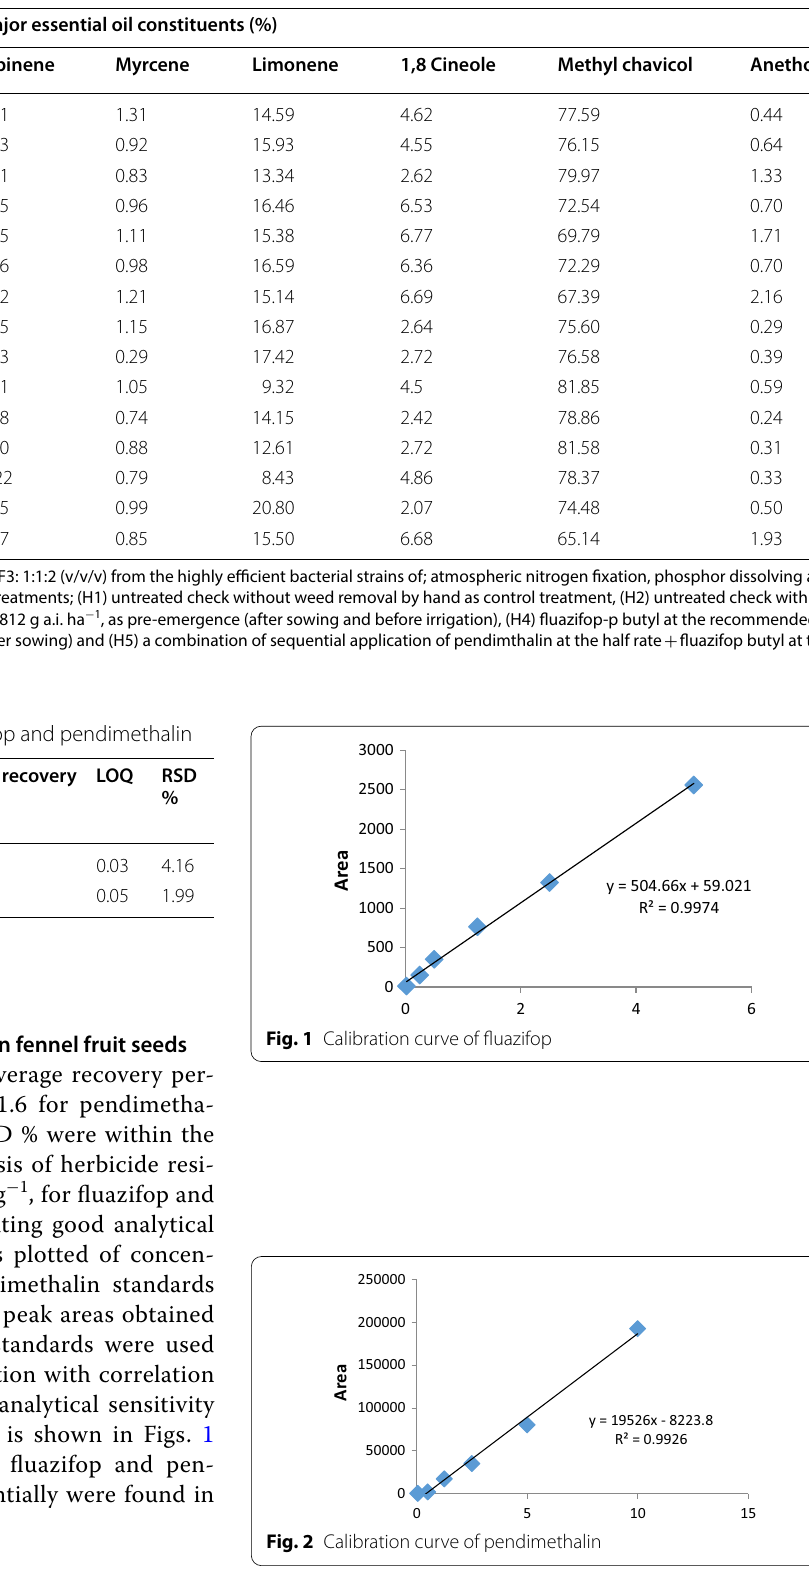
Table 5 Effect of biofertilizer and herbicides on fennel oil composition